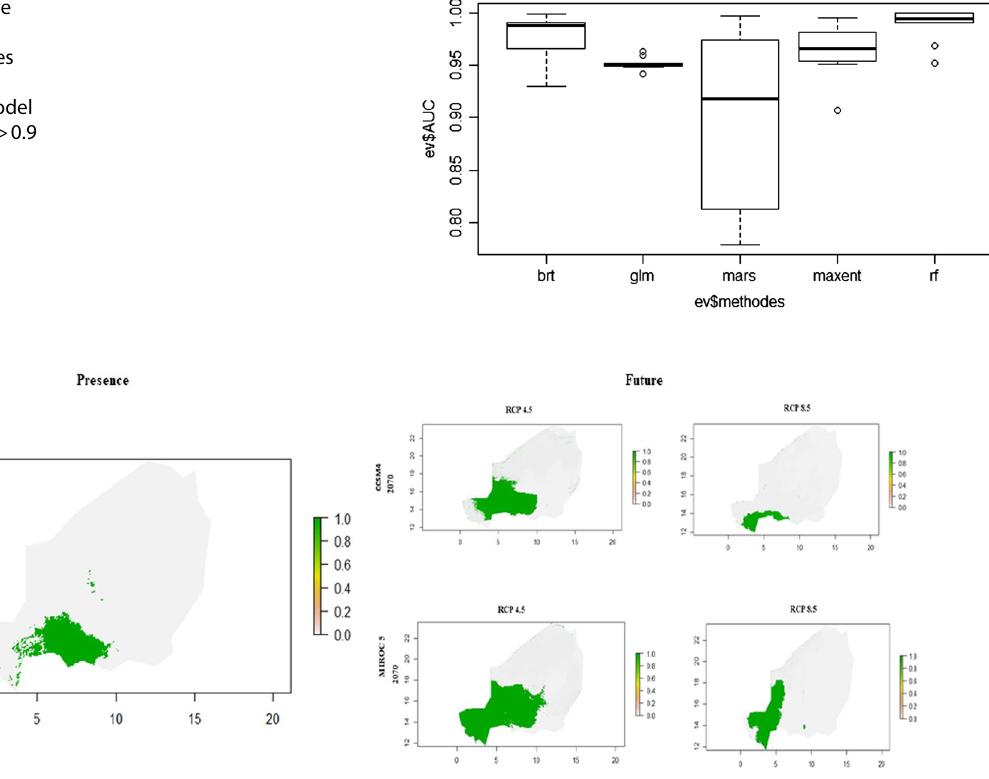
Fig. 4 Occurrence points and predicted distribution of Anogeissus leïocarpa (DC.) Guill. & Perr. over all of